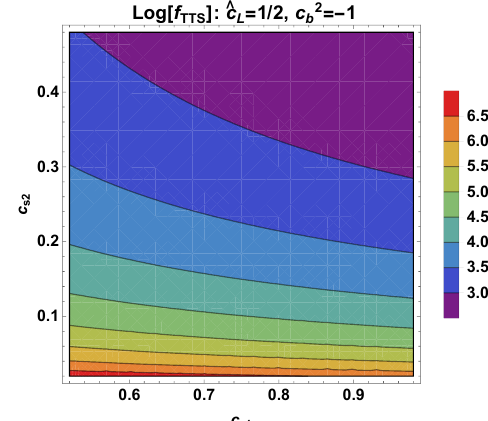
Figure 10 (a). O 3 squeezed vertex. Figure 10 (b). Dominant f (SQ)